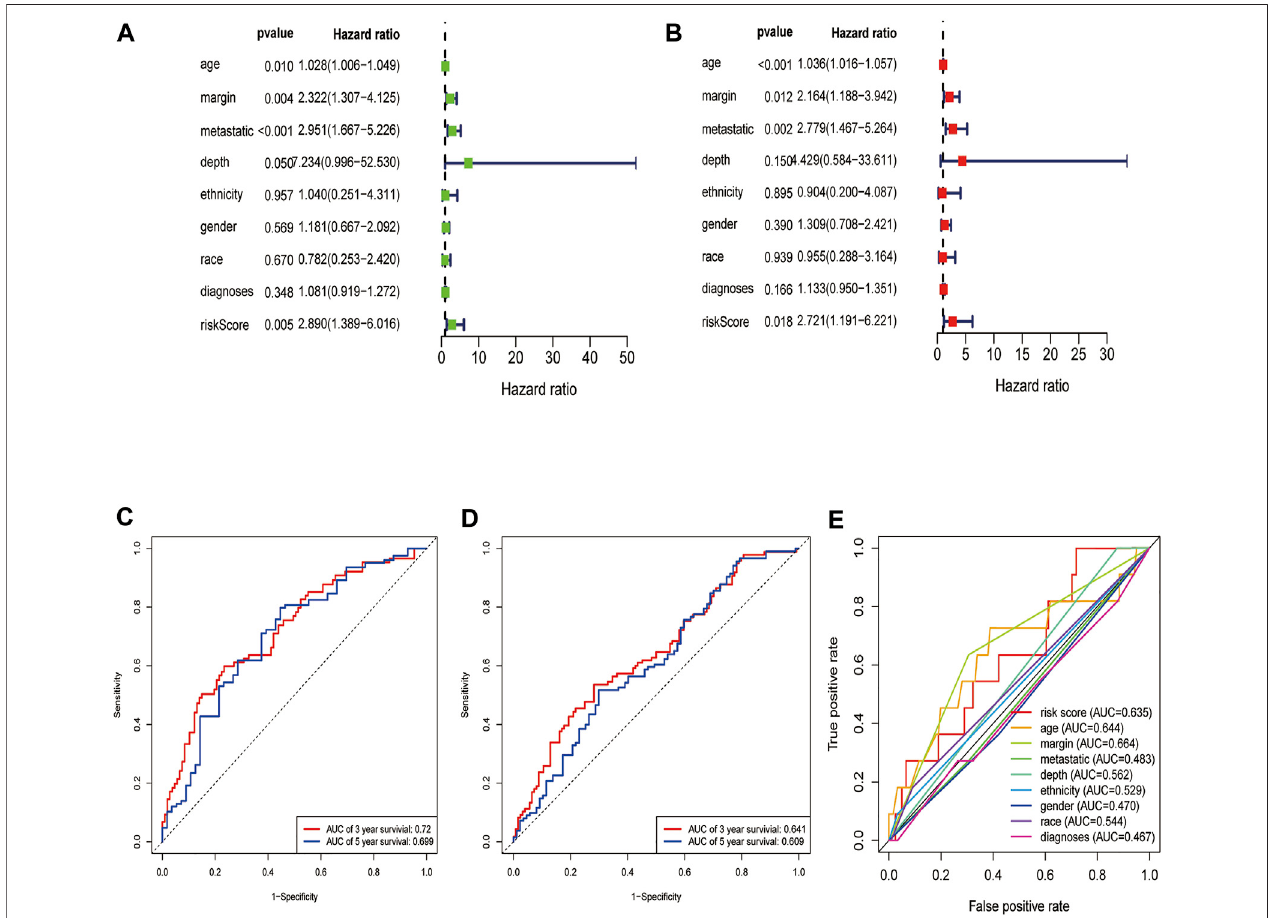
FIGURE8| EvaluationoftheDEGRGssignature.TheResultofunivariateandmultivariateCoxanalyses (A,B) .TheAUCcurvestopredictthesurvivalstatusofSTS patients at the 3- and 5-year survival time in train set (C) , test set (D) .The multi ROC curves of risk model and other clinical characteristic.